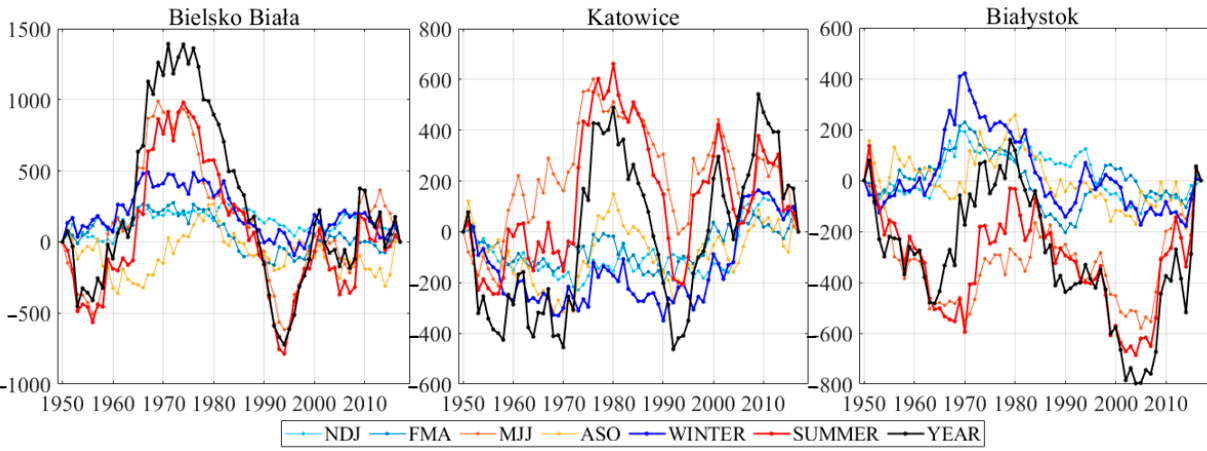
Figure 4. Mass curves of annual mean precipitation ( MP ) in the reduced variable coordinates system. (Values for different of the year, YEAR— MP for the year); MP units mm/year.